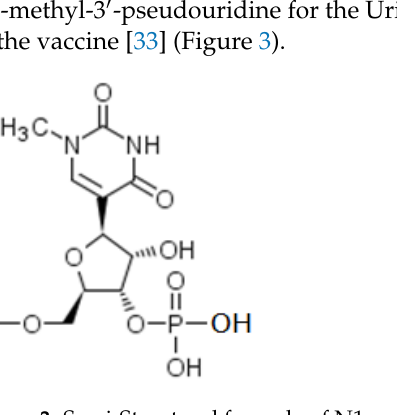
Figure 3. Semi-Structural formula of N1-methyl-3 ’ -pseudo-uridine.